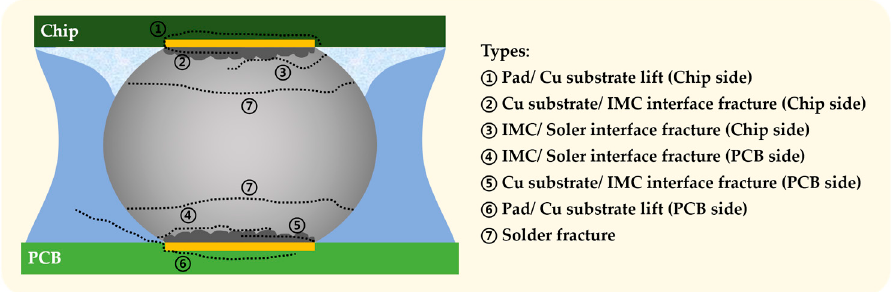
Figure 8. The possible crack path of solder joints from the board level drop test.